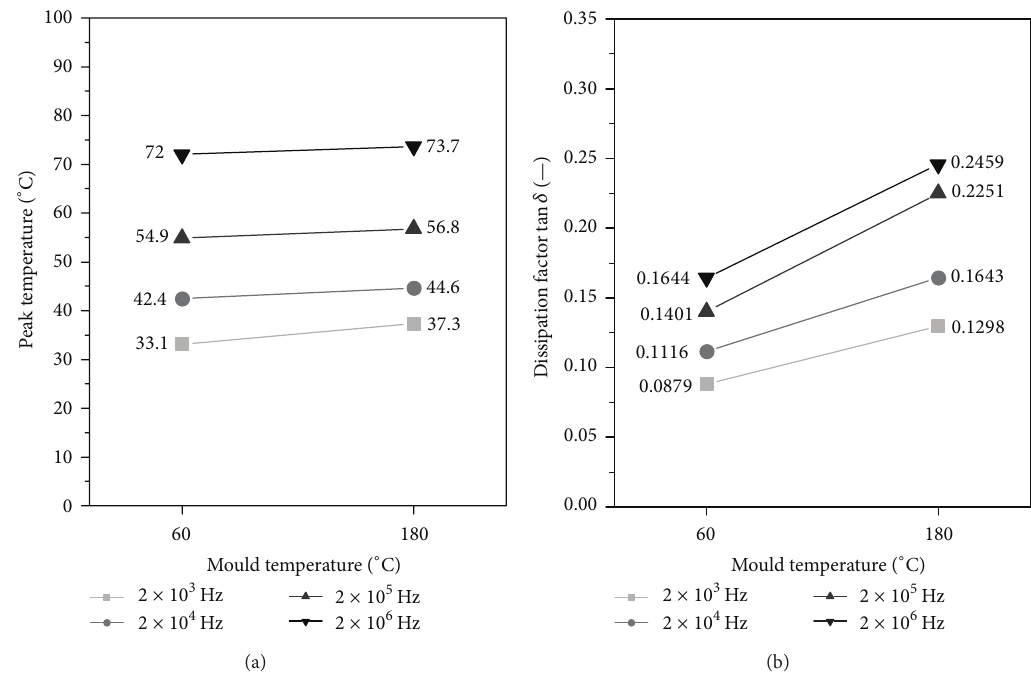
Figure 7: Peak temperature (left) and dissipation factor (right) of the 𝛼 relaxation in dependence of frequency and process conditions.